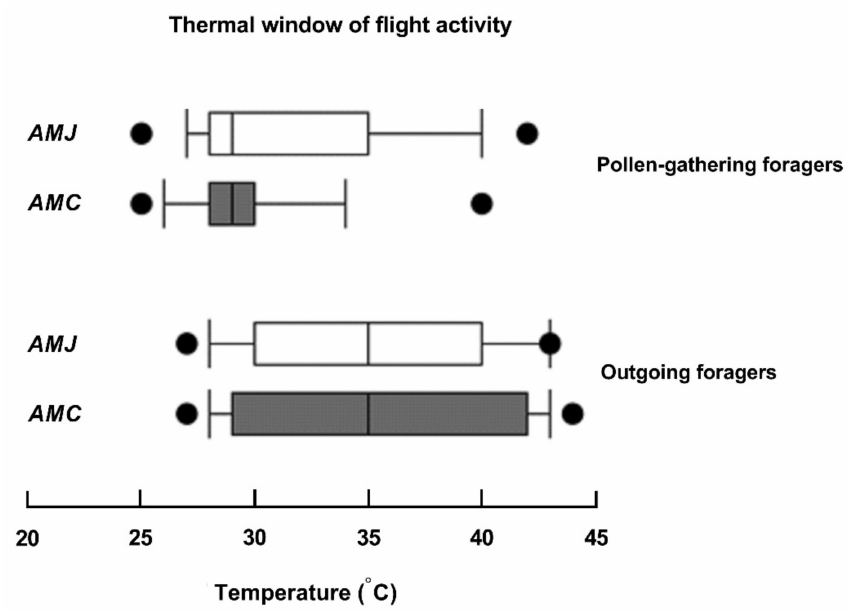
Figure 7. Thermal windows of the foraging flight activities of AMJ and AMC during the flowering seasons of Z. nummularia under hot-arid environmental conditions. The lower panel represents the number of foragers leaving the nests (outgoing foragers), and the upper panel represents the pollen-gathering foragers returning to the nests. The boxes represent the temperature range in which 50% of the foraging activities occurred, and the whiskers indicate the 80% range, while the outliers show the 90%